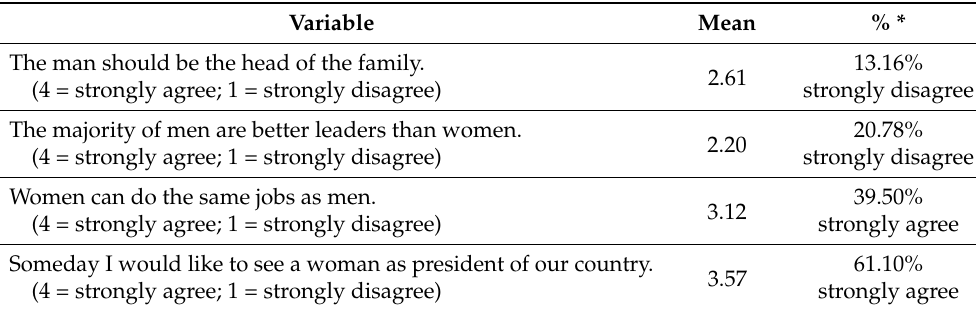
Table 1. Descriptive Summary of Variables Measuring Gender Attitudes.